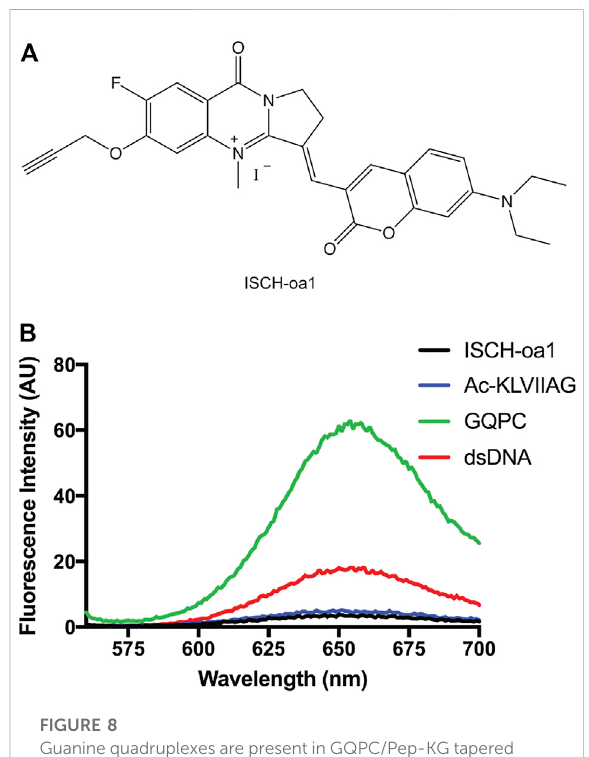
FIGURE 8 Guanine quadruplexes are present in GQPC/Pep-KG tapered nanotubes. ISCH-oa1 (A) was used as a fl uorescent marker of guanine quadruplex folding and presence in conical co- assemblies. In the presence of GQ, ISCH-oa1 showed a marked fl uorescence increase relative to ISCH-oa1 alone or in the presence of other DNA moieties (B) . GQPC indicates GQPC/pep- KG co-assemblies formed in the presence of Na+. Ac-KLVIIAG indicates